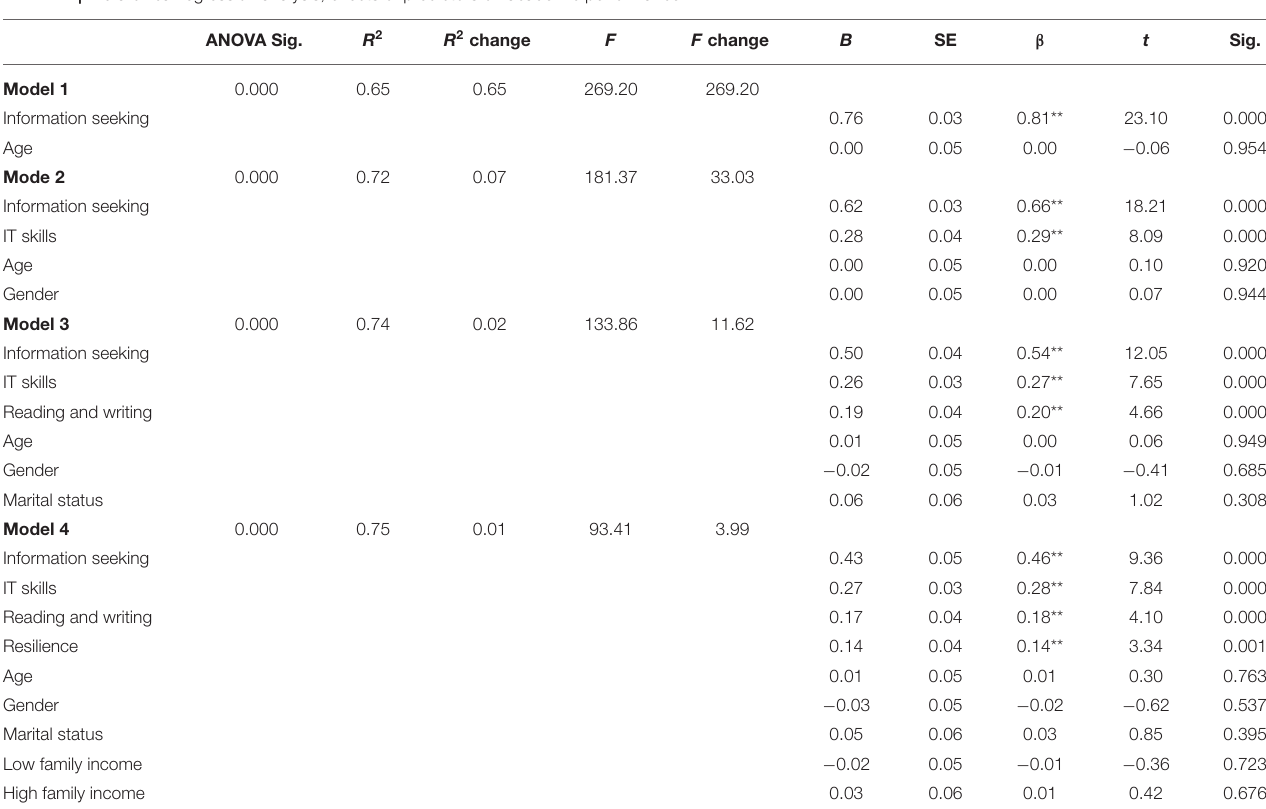
TABLE 4 | Hierarchical regression analysis, effects of predictors on academic performance. ANOVA Sig.